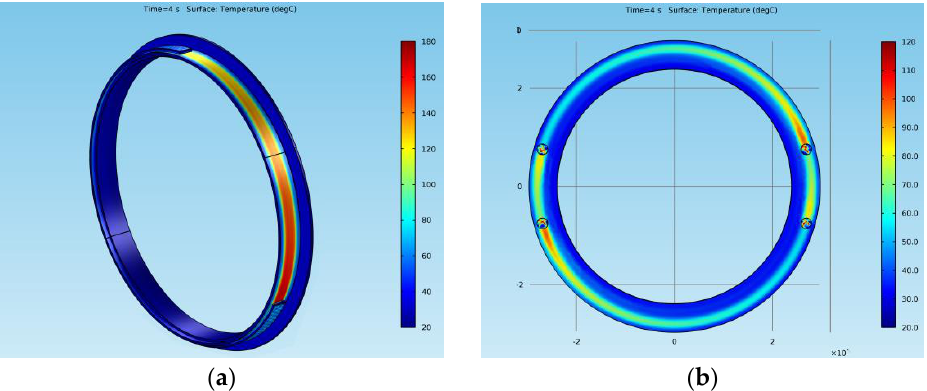
Figure 16. Surface temperature at t = 4 s for ( a ) drum-and-shoe brake system; ( b ) disc-and-pads brake system.